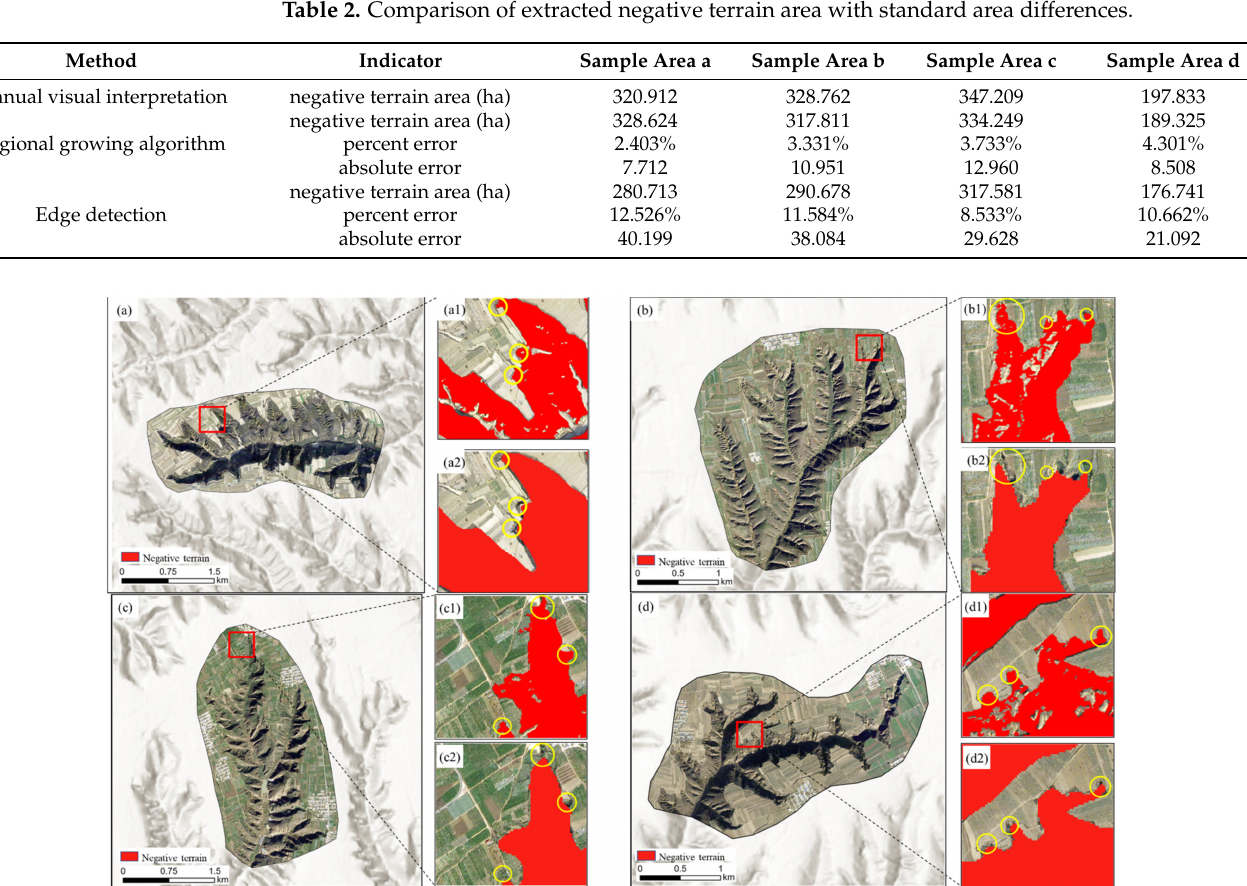
Figure 10. Results of edge detection compared to the regional growing algorithm: ( a – d ) represent 4 sample areas; ( a1 , b1 , c1 , d1 ) represent the results of the edge detection method; ( a2 , b2 , c2 , d2 ) repre- sent the results of the regional growing